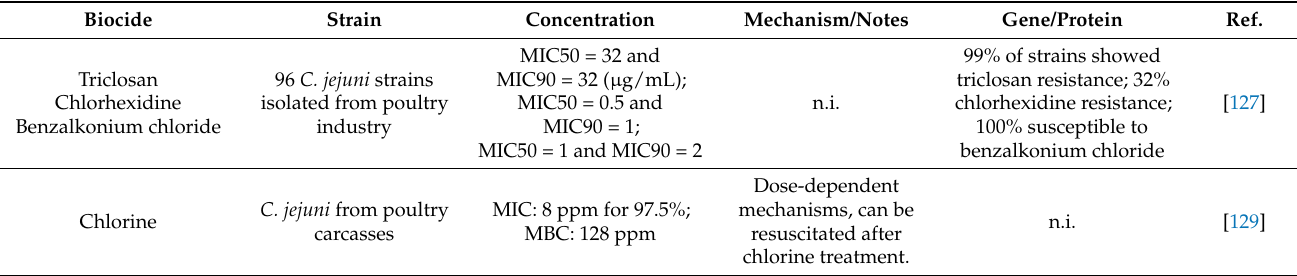
Table 6. Biocides and their impact on Campylobacter